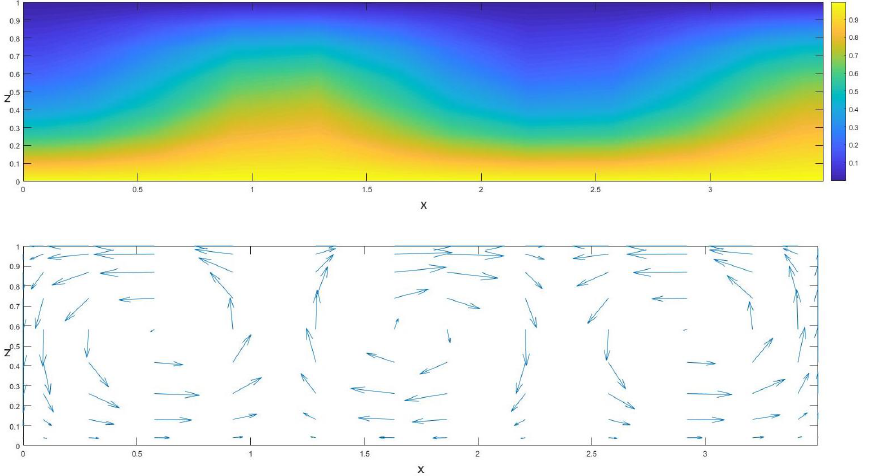
Figure 4. Isotherms and velocity field of the numerical solution obtained with alternating Schwarz; R = 1300 and Γ = 3.495.